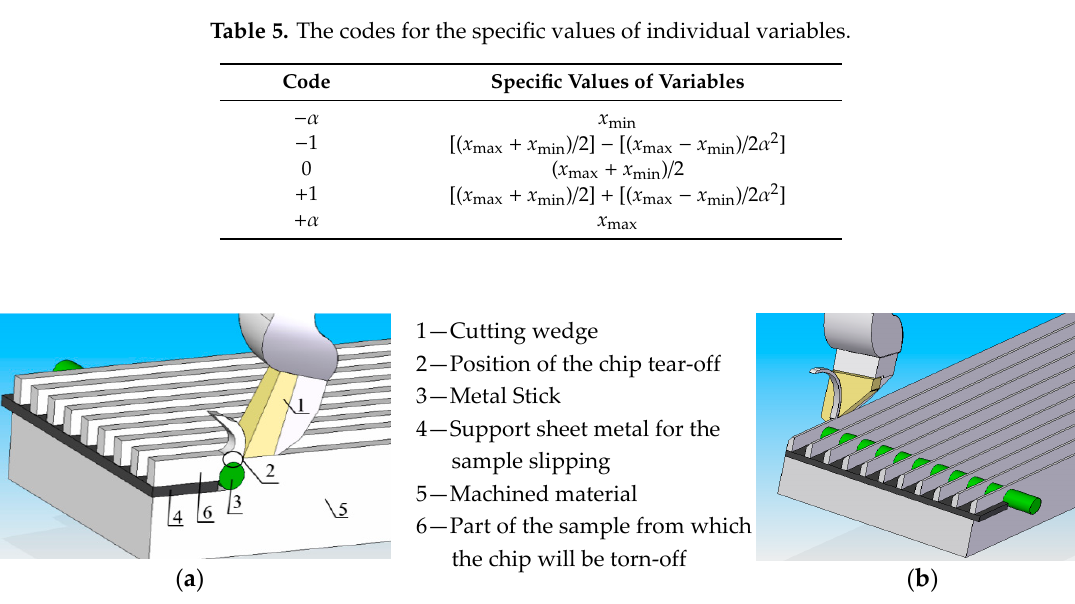
Figure 6. The principle of the designed method for instantaneous contact interruption between the tool and the workpiece; ( a ) orthogonal cutting, ( b ) oblique cutting.